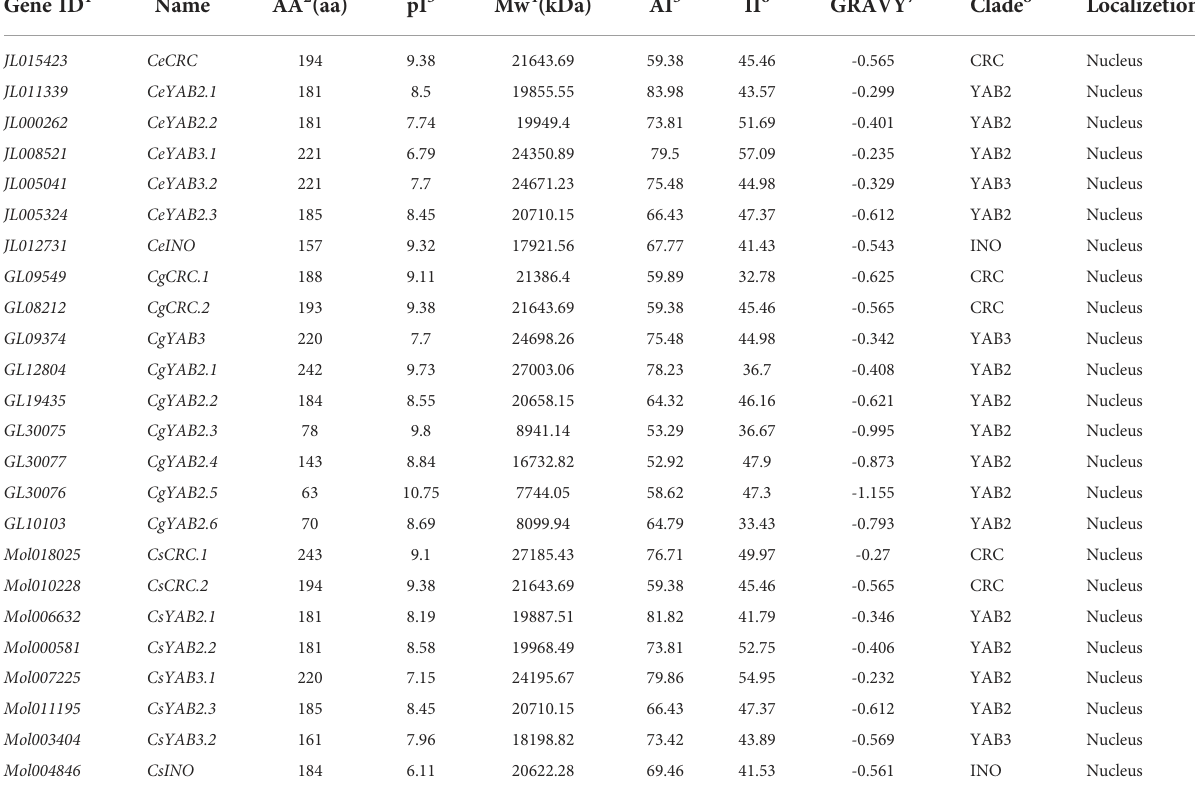
TABLE 1 A list of YABBY genes in three Cymbidium